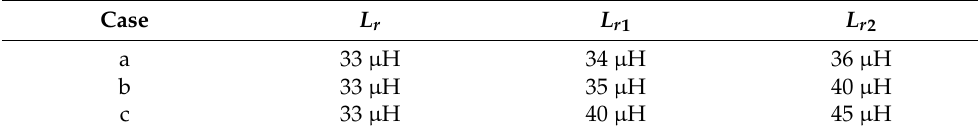
Table 1. Cases based on additional resonant inductor values.